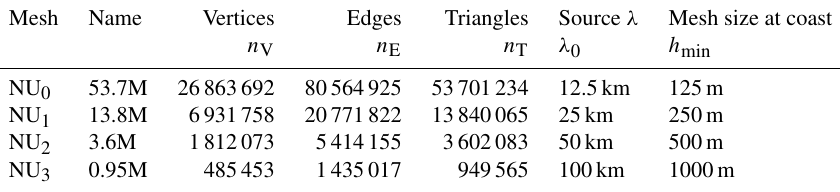
Figure 6. (a) Bathymetry from GEBCO’s geodetic grid is mapped onto a Cartesian grid for use in VOLNA. (b) Uplift caused by a uniform slip of 30m in the four-segment finite fault model (given in Table 2). Table 1. Details of the non-uniform (NU) triangular meshes.